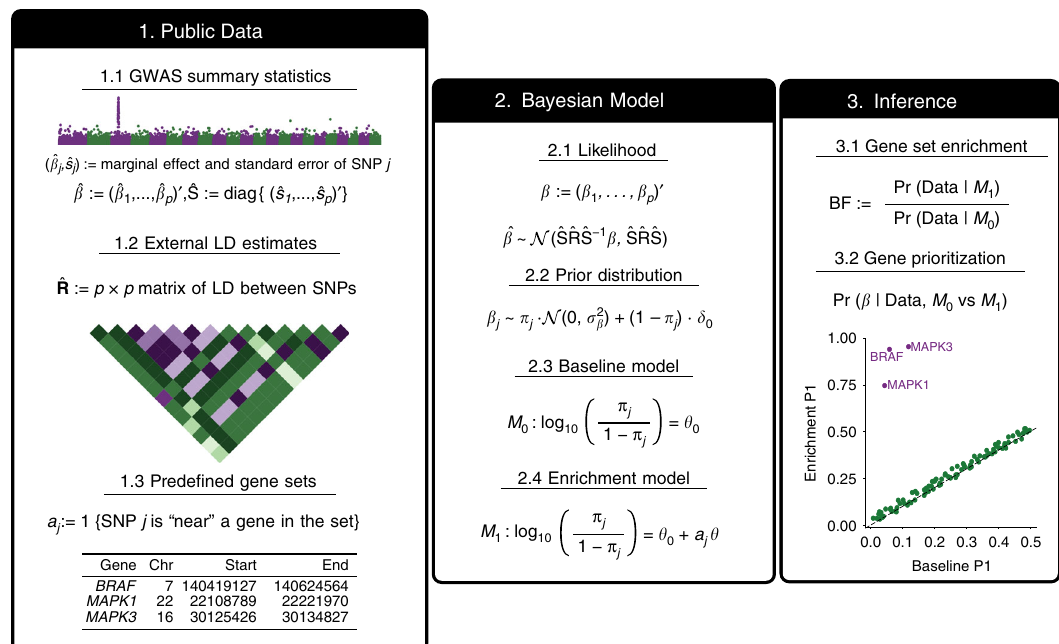
Fig. 1 Schematic overview of RSS-E, a model-based enrichment analysis method for GWAS summary statistics. RSS-E combines three types of public data: GWAS summary statistics (1.1), external LD estimates (1.2), and prede fi ned SNP sets (1.3). GWAS summary statistics consist of a univariate effect size estimate ( ^ β ) and corresponding standard error ( ^ s ) for each SNP, which are routinely generated in GWAS. External LD estimates are obtained from an j j external reference panel with ancestry matching the population of GWAS cohorts. SNP sets here are derive from gene sets based on biological pathways or sequencing data. We combine these three types of data by fi tting a Bayesian multiple regression (2.1 – 2.2) under two models about the enrichment parameter ( θ ): the baseline model (2.3) that each SNP has equal chance of being associated with the trait ( M 0 : θ = 0), and the enrichment model (2.4) that SNPs in the SNP set are more often associated with the trait ( M 1 : θ > 0). To test enrichment, RSS-E computes a Bayes factor (BF) comparing these two models (3.1). RSS-E also automatically prioritizes loci within an enriched set by comparing the posterior distributions of genetic effects ( β ) under M 0 and M 1 (3.2). Here we summarize the posterior of β as P 1 , the posterior probability that at least one SNP in a locus is trait-associated. Differences between P 1 estimated under M 0 and M 1 re fl ect the in fl uence of enrichment on genetic associations, which can help identify new trait-associated genes